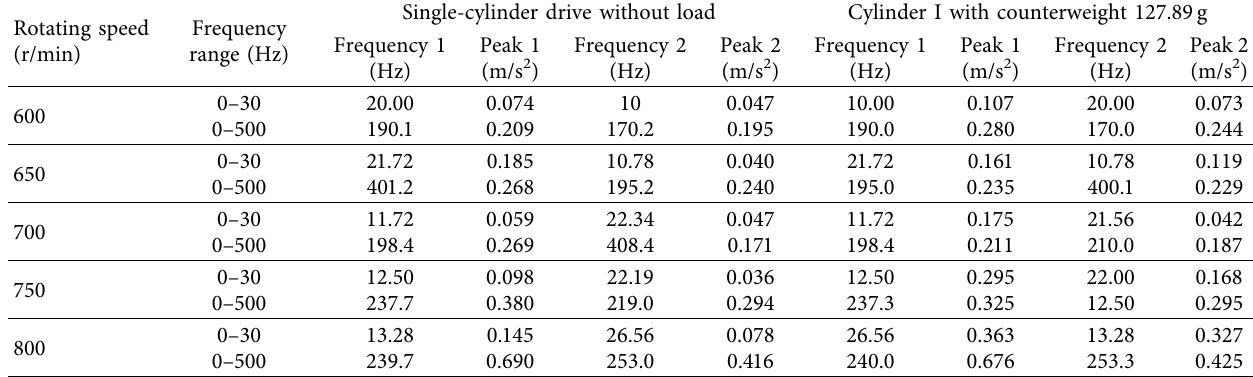
Figure 18: Single-cylinder frequency spectrum in the range of 0–30Hz and 0–500 Hz. (a) Spectrogram of single cylinder in the range of 0–30Hz. (b) Spectrogram of single cylinder in the range of 0–500 Hz. Table 3: FFT main data of vibration acceleration of single-cylinder drive cylinder I at the horizontal position of bearing seat in the Y